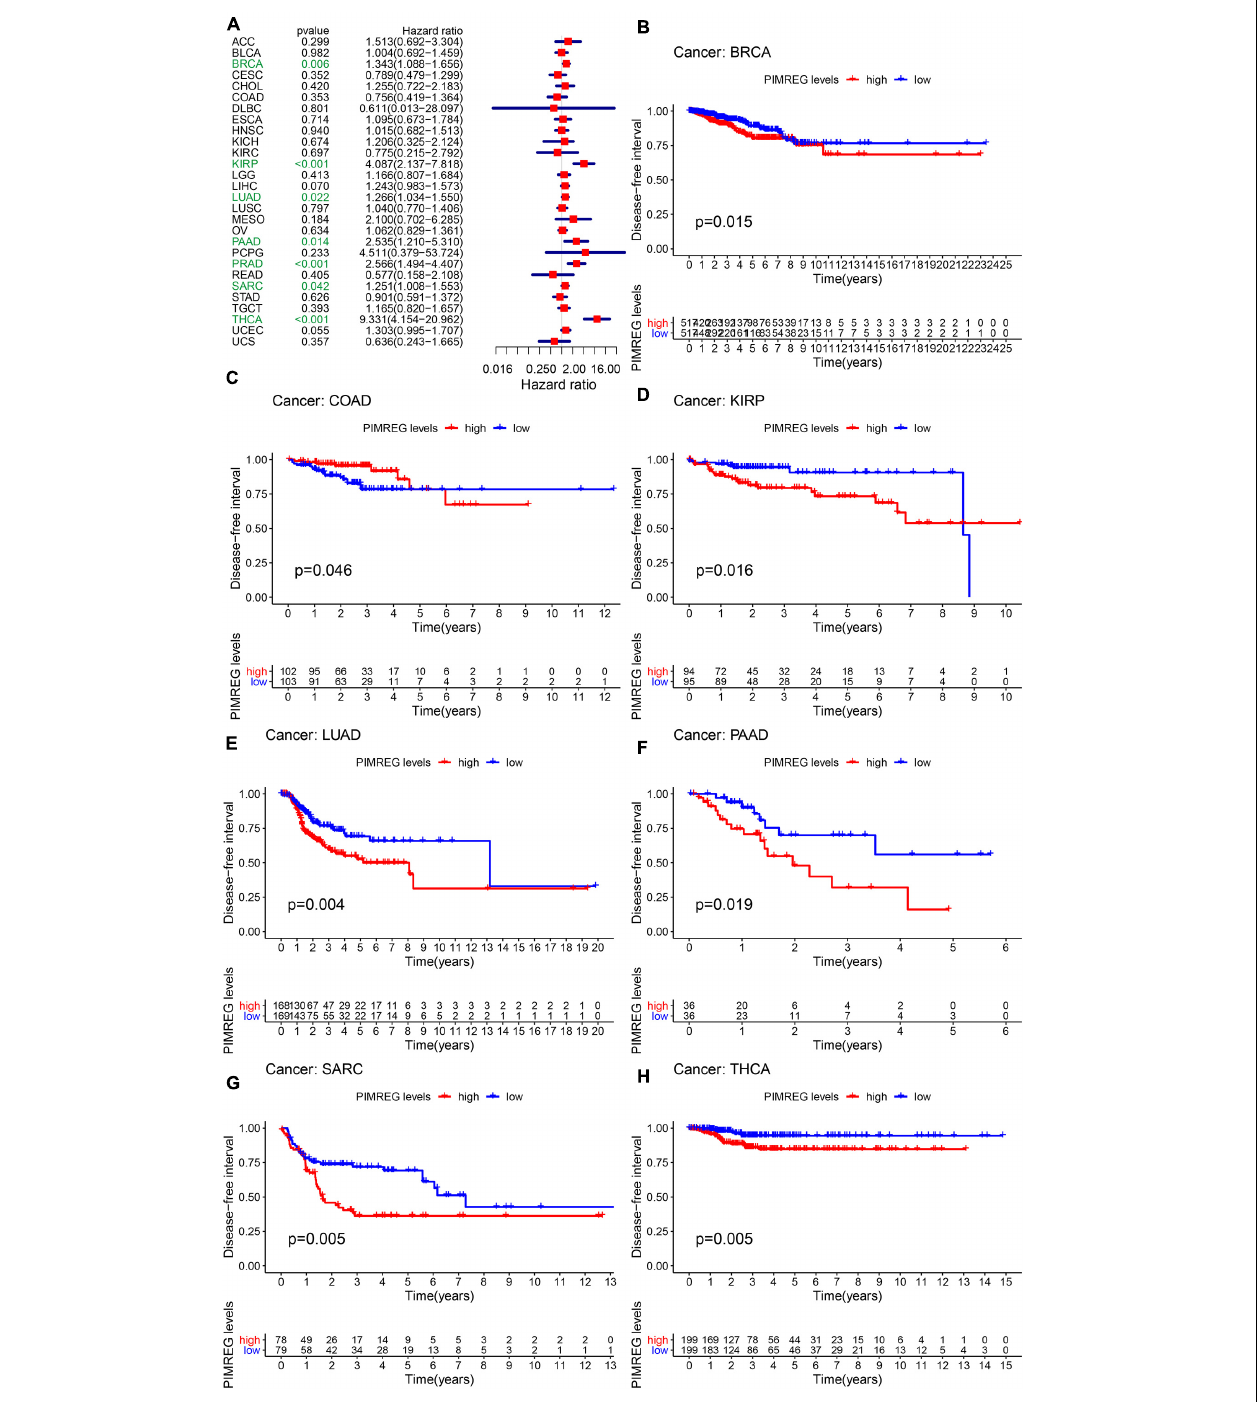
FIGURE 5 | Correlation between the expression of PIMREG and disease-free interval (DFI). (A) Forest plots of the expression of PIMREG in 33 tumors in association with DFI. (B–H) KM analyses of the relationship between PIMREG expression and DFI.